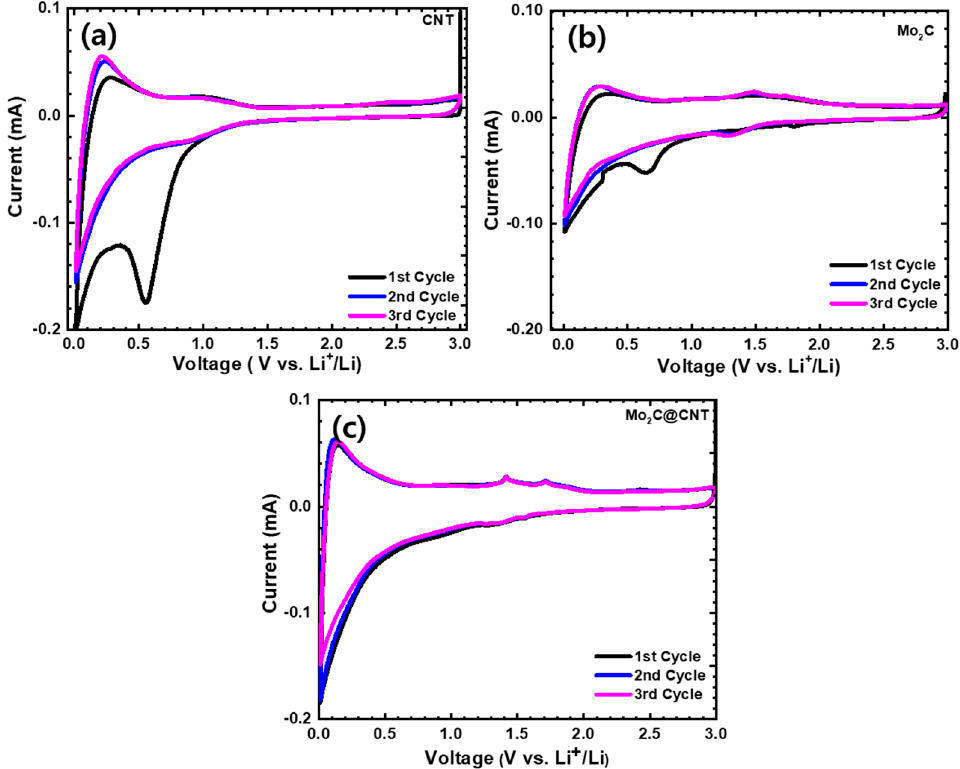
Figure 6. Cyclic voltammograms at 0.1 mV.s − 1 in the range of 0.01–3.0 V for ( a ) CNT, ( b ) Mo 2 C, and ( c ) Mo 2 C@CNT hybrid anodes.